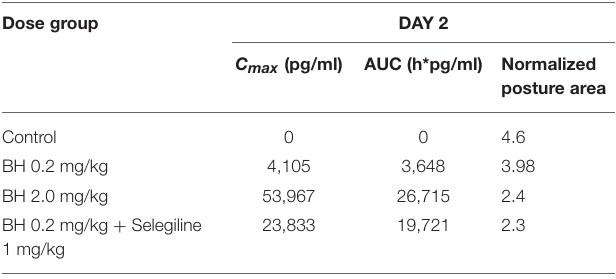
TABLE 3 | PK/PD correlation on day 2 of treatment with different doses of betahistine and co-medication of betahistine with the MAO-B inhibitor selegiline. Dose group DAY 2